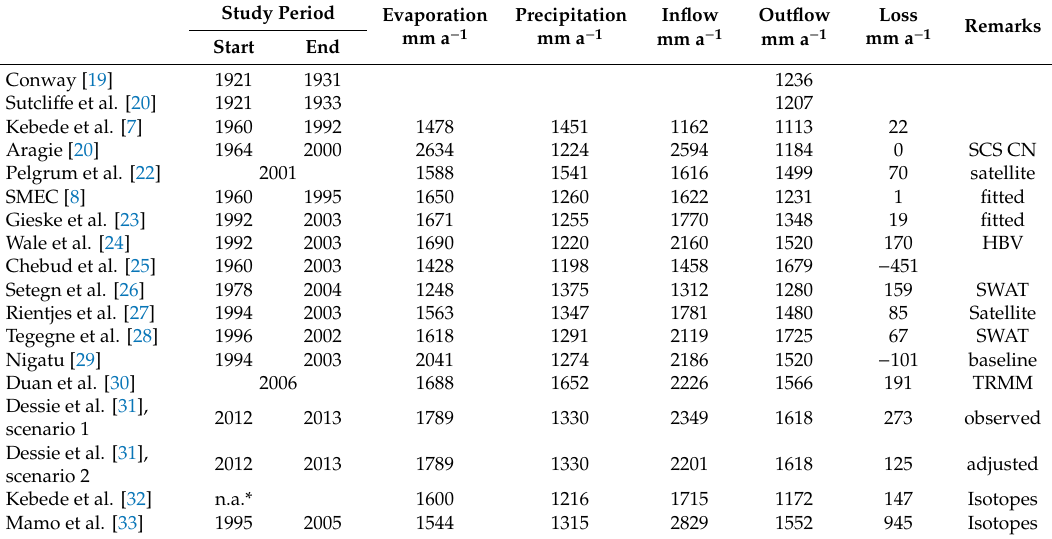
Table 1. A review of the previous studies on Lake Tana water balance